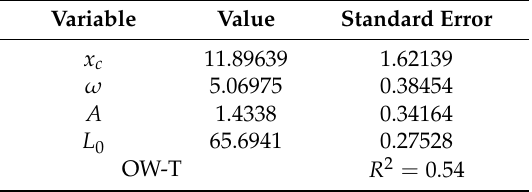
Table 12. Correlation modeling between Temperature and Noise Level at OW-T.